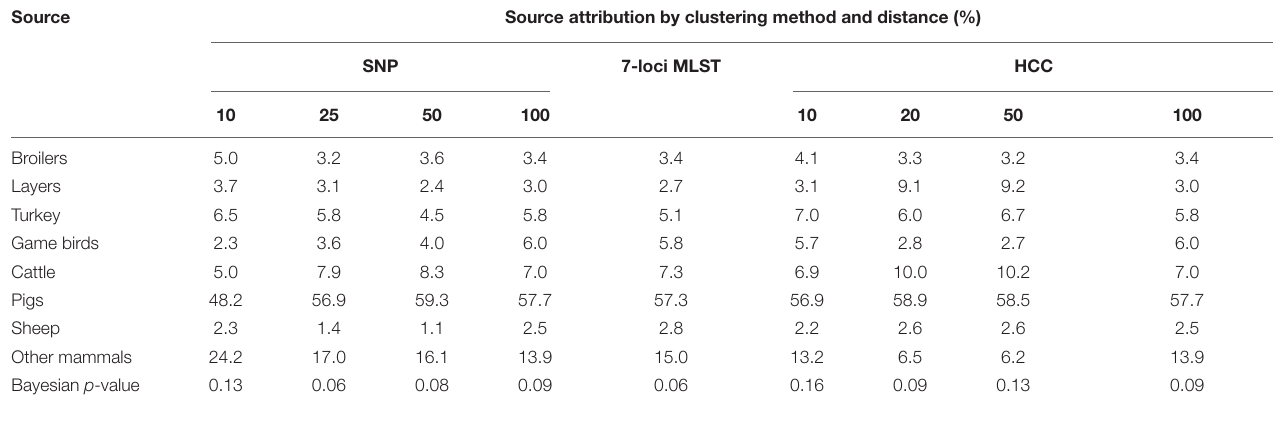
TABLE 4 | Source attribution (%) and model fit (in terms of Bayesian p -value) for England and Wales from Salmonella Typhimurium and monophasic variants, estimated from a Bayesian model applied to three different methods of strain